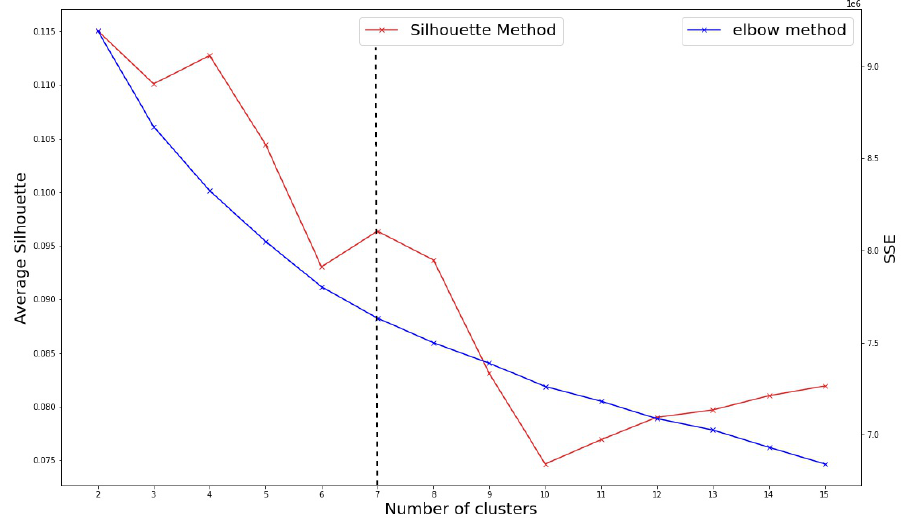
Figure 8. Graph of the SSE vs. Number of clusters. The point of inflection of the curve is at 7 according to the elbow method and in combination with the silhouette